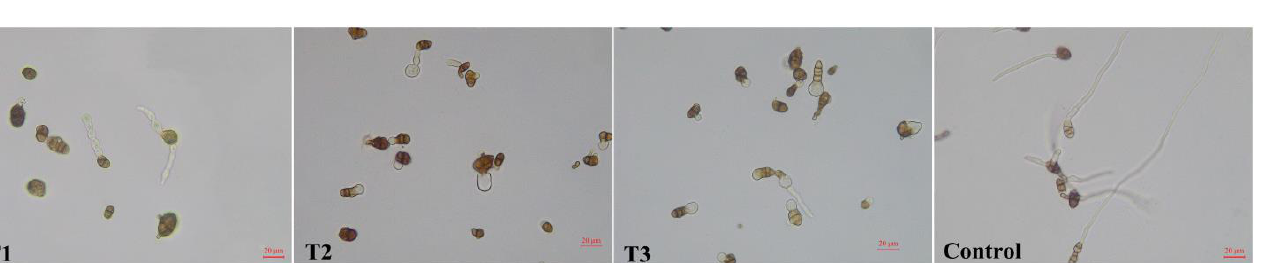
Table 2. Effect of aseptic filtrate on conidia germination of Alternaria alternata.